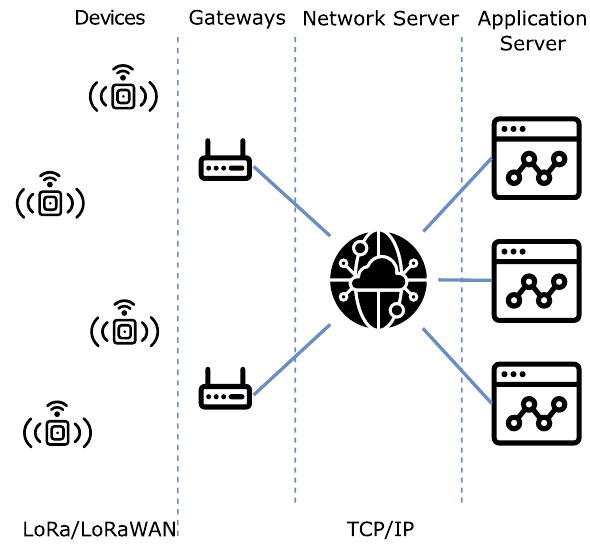
Figure 1. High-level view of the LoRaWAN